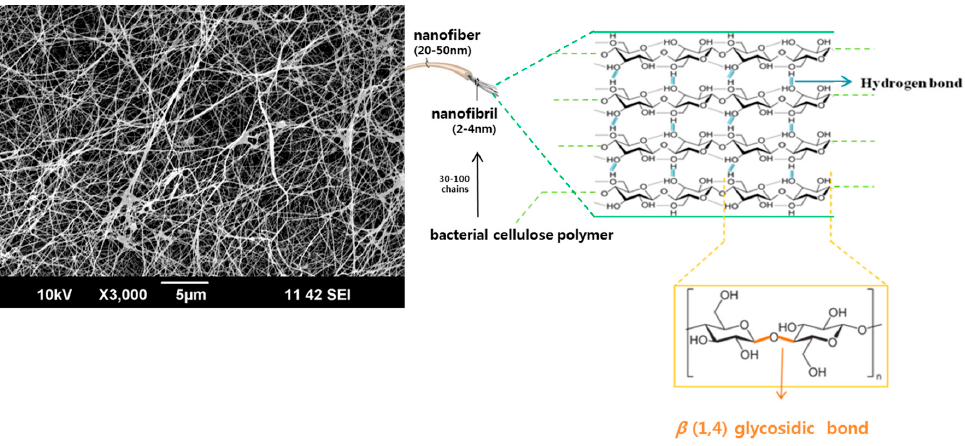
Figure 1. Schematic of bacterial cellulose structure.